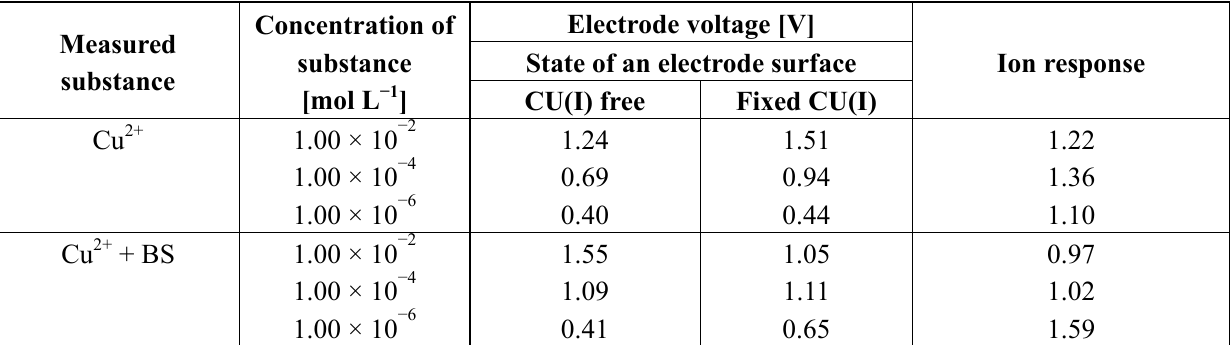
Table 3. Detected electrode voltage by host-guest reaction (Type II). (1) Detection of Cu 2+ by CU(I) fixed on an